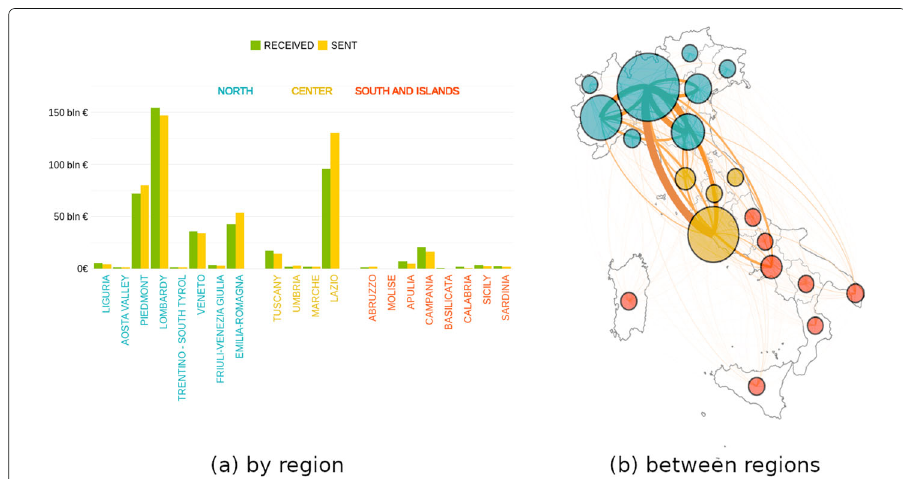
Fig. 17 Wire transfers total amount by (left) and between (right) regions: Northern bank accounts are on average richer than Southern bank accounts. Lombardy and Lazio emerge as the main economic centres of the country (confirmed by the official GDP per capita distribution, as in Fig. 3). We show also exchanges between regions: the width of each edge is proportional to the total amount transferred from one region to another, with directions to be read clockwise; each node’s size represents out-strength of the related region, and the geographical area it belongs to. Richer Northern regions are the most interconnected and wider flows are exchanged between Lombardy, Piedmont, Veneto, Emilia-Romagna and Lazio (the only region from the Centre belonging to the “richest club”)